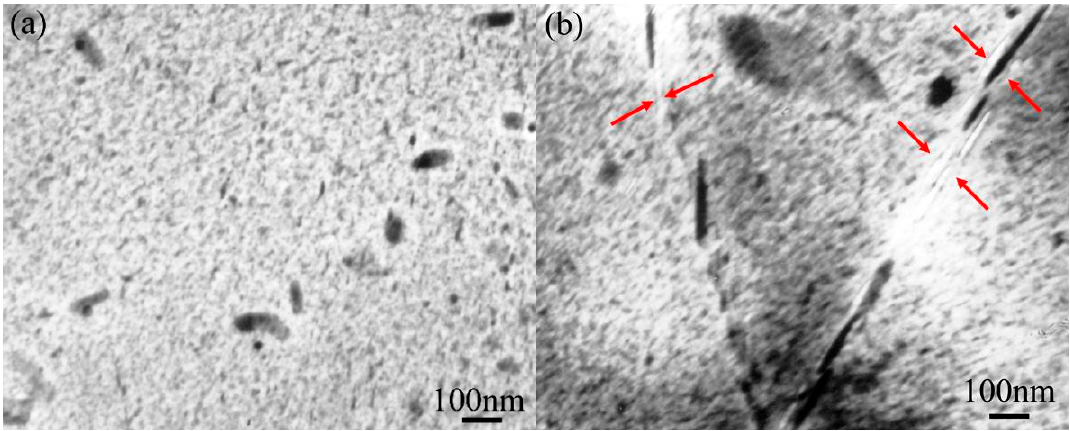
Figure 9. TEM micrographs showing microstructures of the over-aged 7050 aluminum alloy ( a ) precipitates inside grains; ( b ) precipitates in grain boundaries and subgrain boundaries.